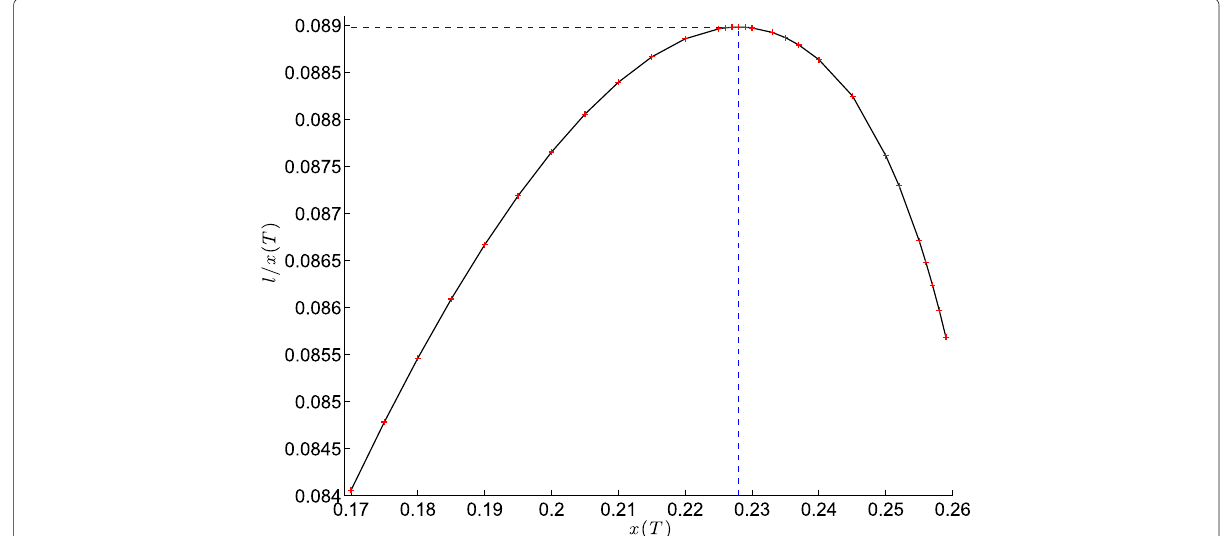
Fig. 15 Efficiency curve for the mechanical cost and the corresponding minimizing curve with the best performance is represented in Fig.14. Note that the efficiency of the abnormal curve is 5.56 e − 2 vs of order 8.89 e − 2 for normal strokes